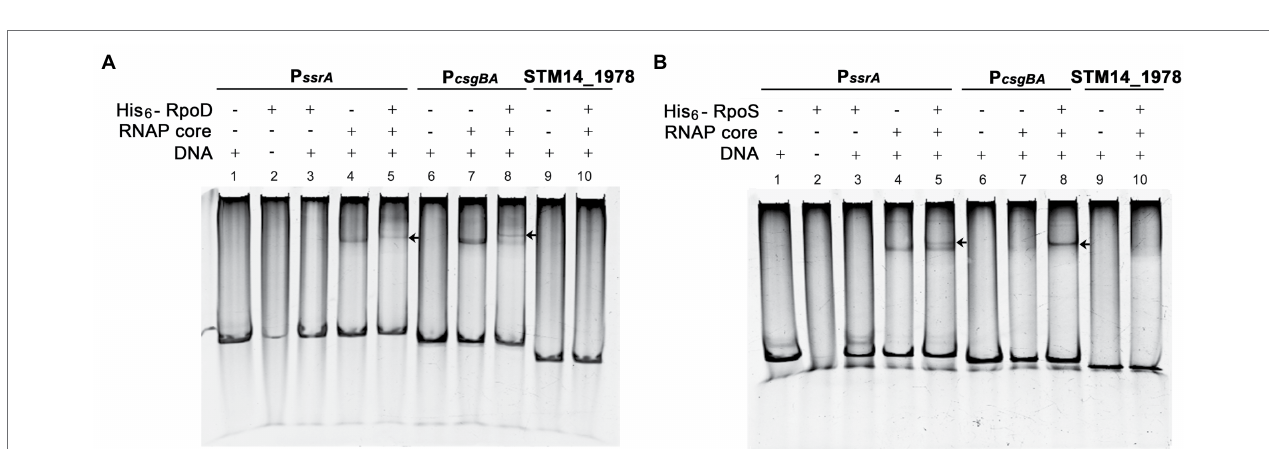
FIGURE 6 | Interaction of P ssrA with either σ S or σ 70 in vitro . Binding of His 6 -RpoD (A) and His 6 -RpoS (B) to the ssrA promoter region was tested in vitro using EMSA. DNA fragments of the P ssrA region (178 bp), P csgBA region (158 bp; a positive control), and STM14_1978 CDS region (148 bp; a negative control) were incubated with RNA polymerase (RNAP) core enzyme in combination with His 6 -RpoD or His 6 -RpoS. The DNA-protein complexes were loaded onto a 5% native polyacrylamide gel and stained with EtBr. An arrow indicates a shifted band comprising P ssrA or P csgBA DNA cross-linked with the RNAP